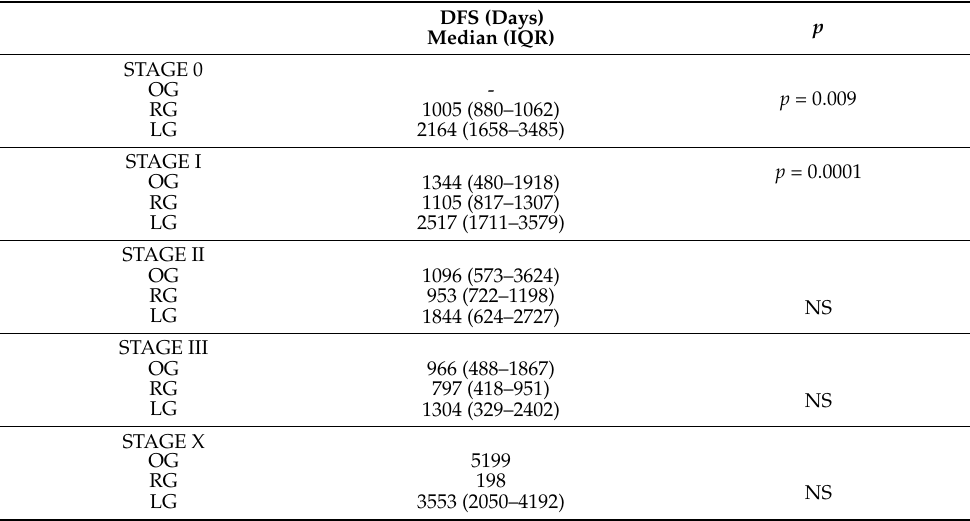
Table 6. DFS as a function of the three different approaches and of the tumor